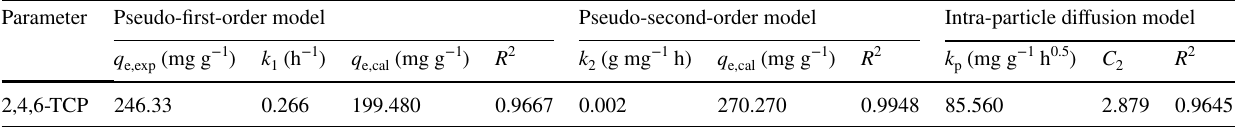
Table 9 Kinetic models parameters for the adsorption of 2,4,6-TCP onto CSSS-AC at 30 °C Parameter Pseudo-first-order model Pseudo-second-order model Intra-particle diffusion